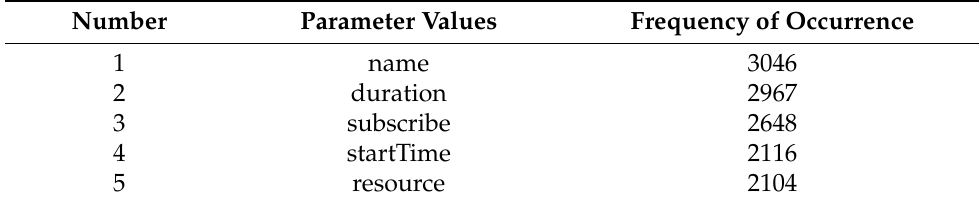
Table 3. Top five high-frequency words in the normal sample.